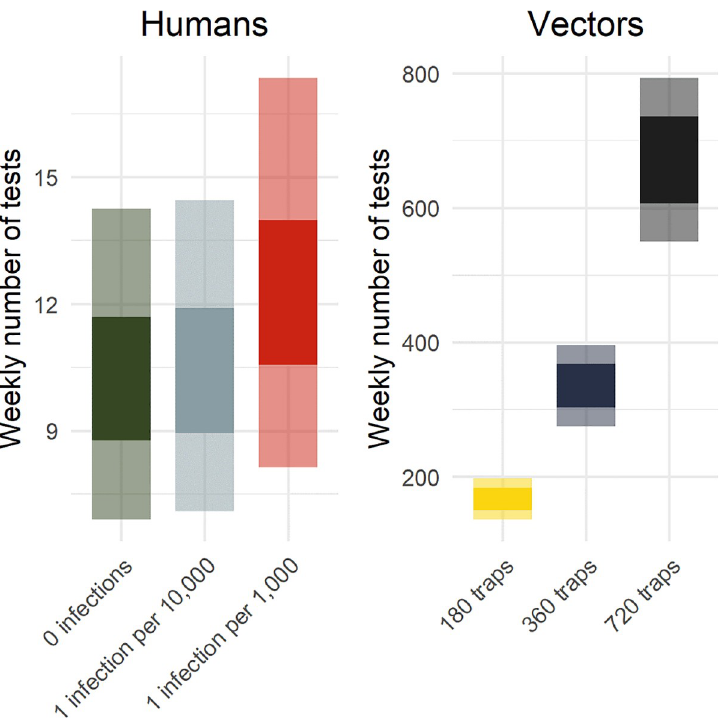
Fig 2. Expected number of tests for vector and human surveillance strategies. This figure shows the 50% uncertainty interval (UI, dark) and 95% UI (light) for the expected number of RT-PCR tests required per week for different surveillance strategies and transmission levels in a population of 100,000 people. The human surveillance strategy indicates the number of tests among emergency department patients with two or more ZIKV symptoms given transmission scenarios of 0 (green), 1 (grey), and 10 (red) infections per 10,000 people per week. The yellow, blue, and black bars are the number of tests required for pools of female Ae . aegypti for different numbers of traps in the same